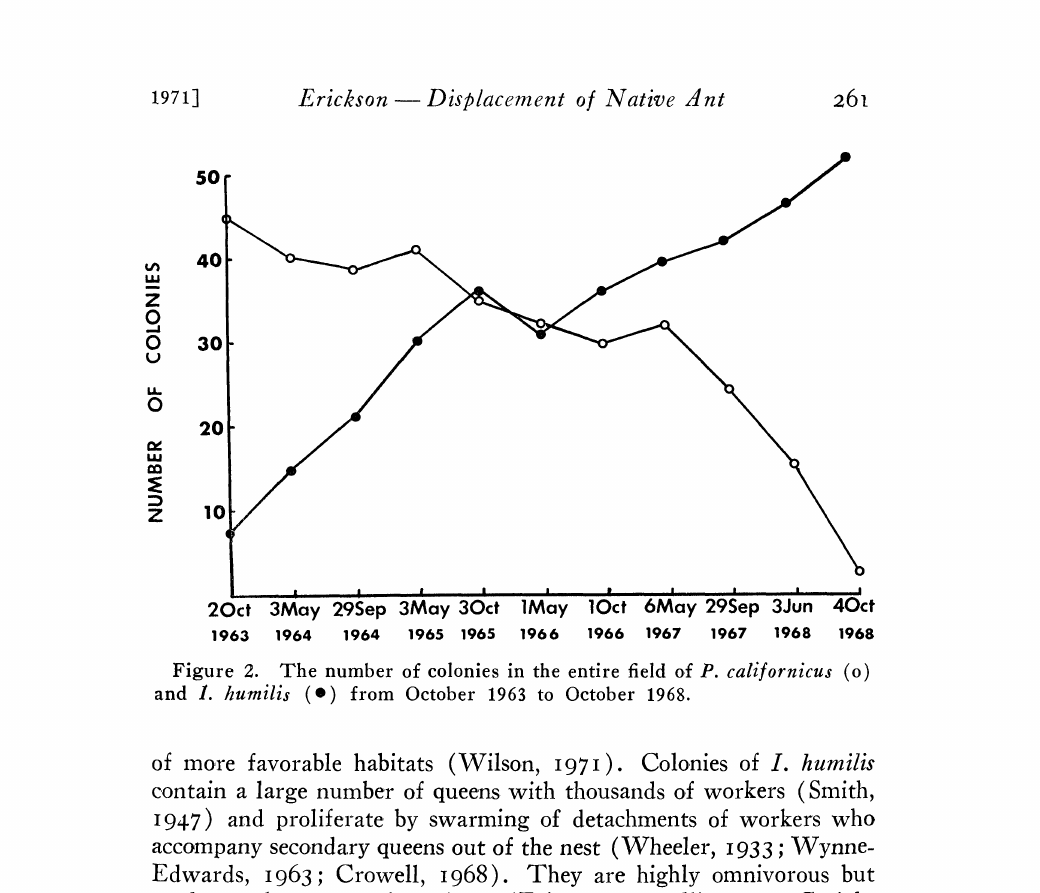
Figure 2. The number of colonies in the entire field of P. californicus (o) and 1. humilis (e) from October 1963 to October 1968. of more favorable habitats (Wilson, 1971). Colonies of I. humilis contain a large number o.f queens with thousands o.f workers (Smith, I947) and proliferate by swarming of detachments of workers who accompany secondary queens out of the nest (Wheeler, I933; Wynne- Edwards, I963; Crowell, I968). They are highly omnivorous but tend to. seek sweet or fatty foods (Eckert and Mallis, I937; Creigh- ton, I96o’; Cook, I953), and tend aphids and scale insects in orchards and gardens (Skaife,,